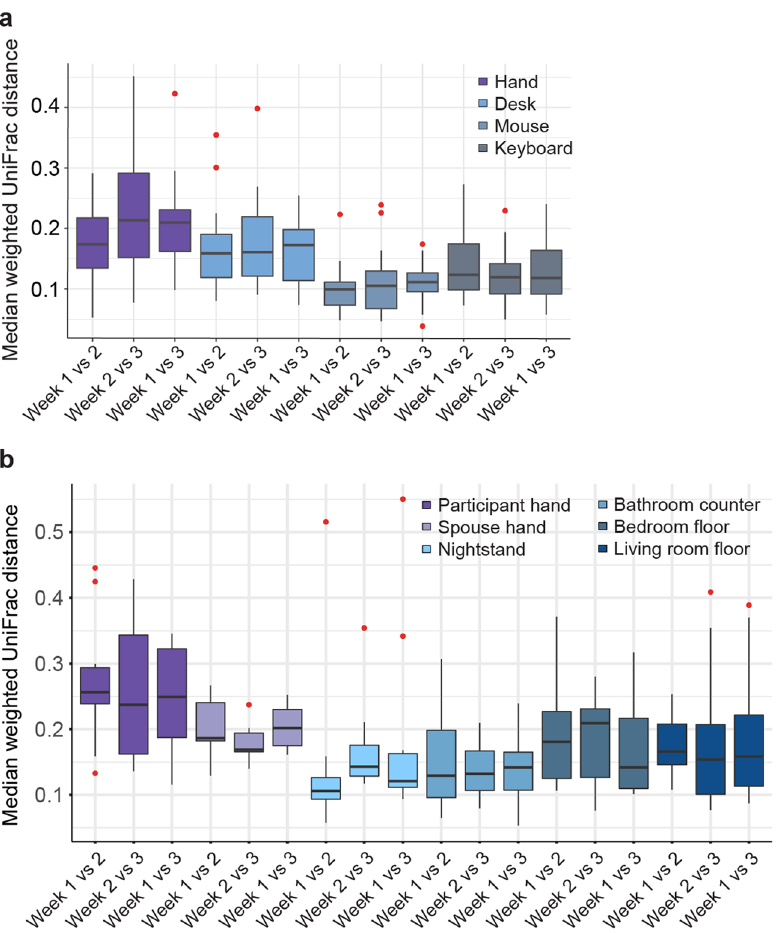
Figure 2. Longitudinal stability of microbial communities (weighted UniFrac) within each participant colored by sample type in the office and home environments: ( a ) boxplot representing median weighted UniFrac distances within each participant colored by sample type between the weeks of sampling for the office environment. Sample sizes can be found in Supplementary Table 1; ( b ) boxplot representing median weighted UniFrac distances within each participant colored by sample type between pairs of the weeks of sampling for the home environment. Sample sizes can be found in Supplementary Table